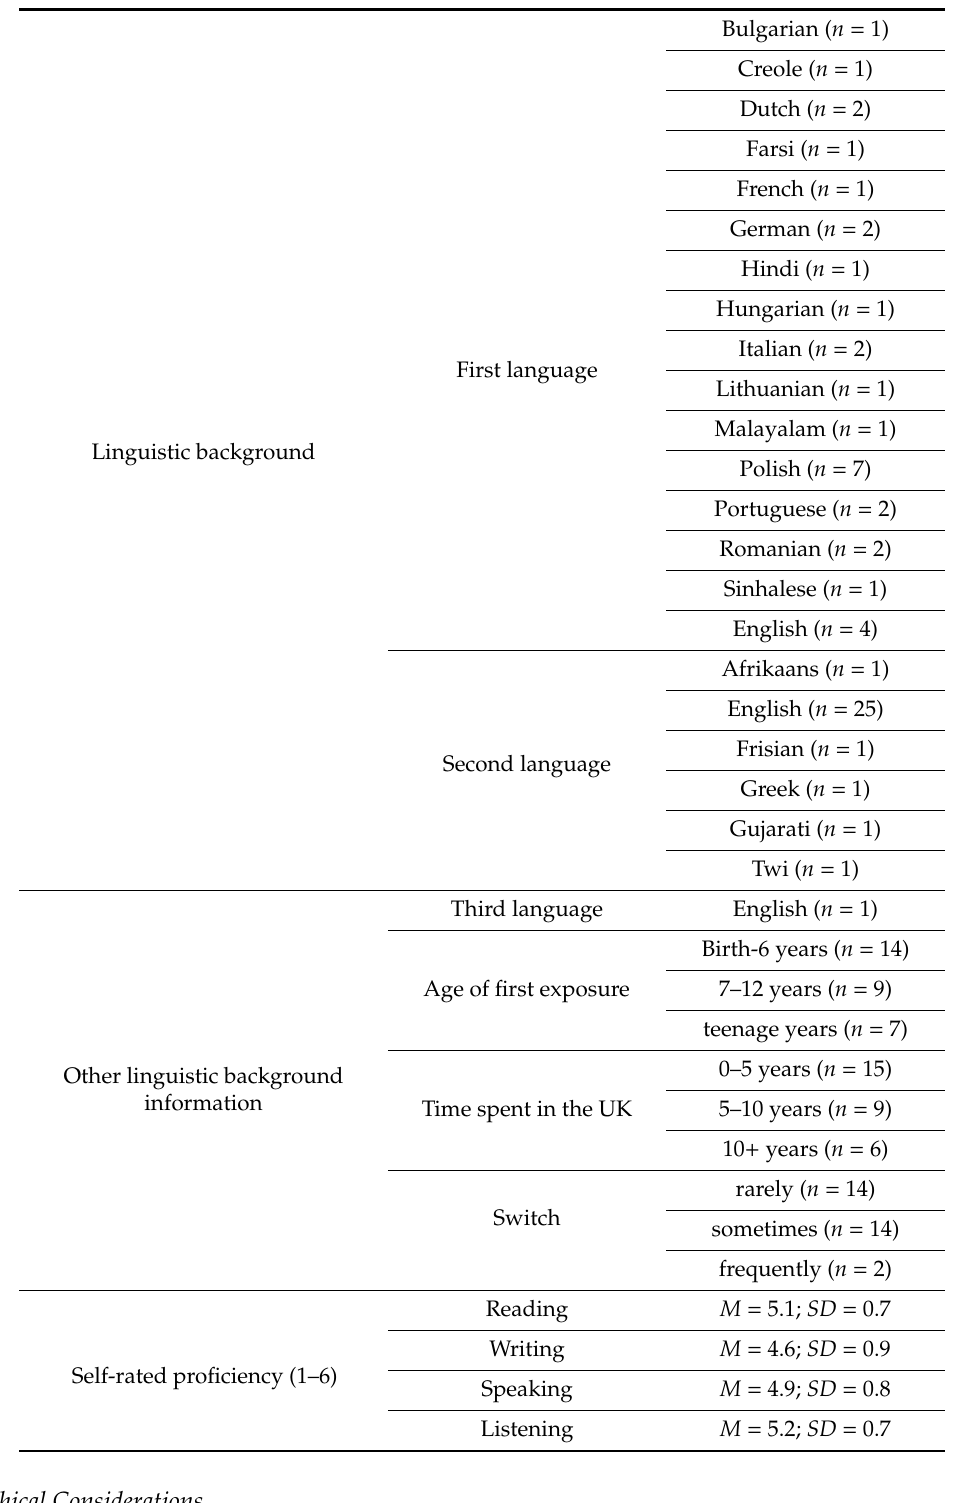
Table 1. Bilingual participants’ levels of self-rated English Language